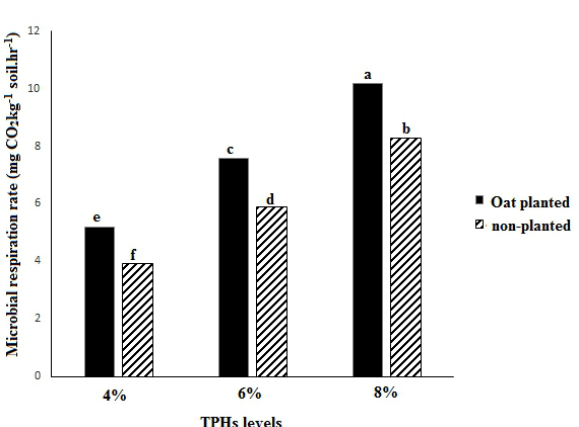
Fig. 1. Comparison of mean microbial respiration rate at various TPH levels in planted and unplanted soils Note: Mean values followed by the same letters are not significantly different (P≤0.05) according to Duncan’s multiple range test